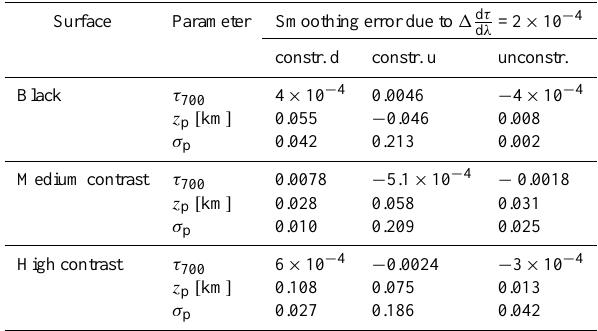
Table 4. Errors caused in the retrieval of other retrieved parameters at the maximum deviation of d τ from its assumed d λ